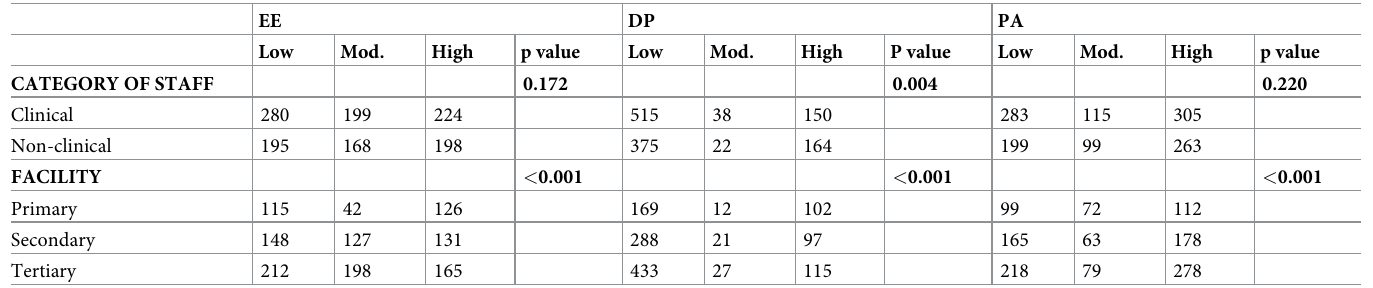
Prevalence of burnout among participants The percentage of participants with burnout as defined as participants with the three defining characteristics of burnout; high EE, high DP and low PA was 260 (20.57%). Compared to the Table 2. Distribution of elements of burnout syndrome among the